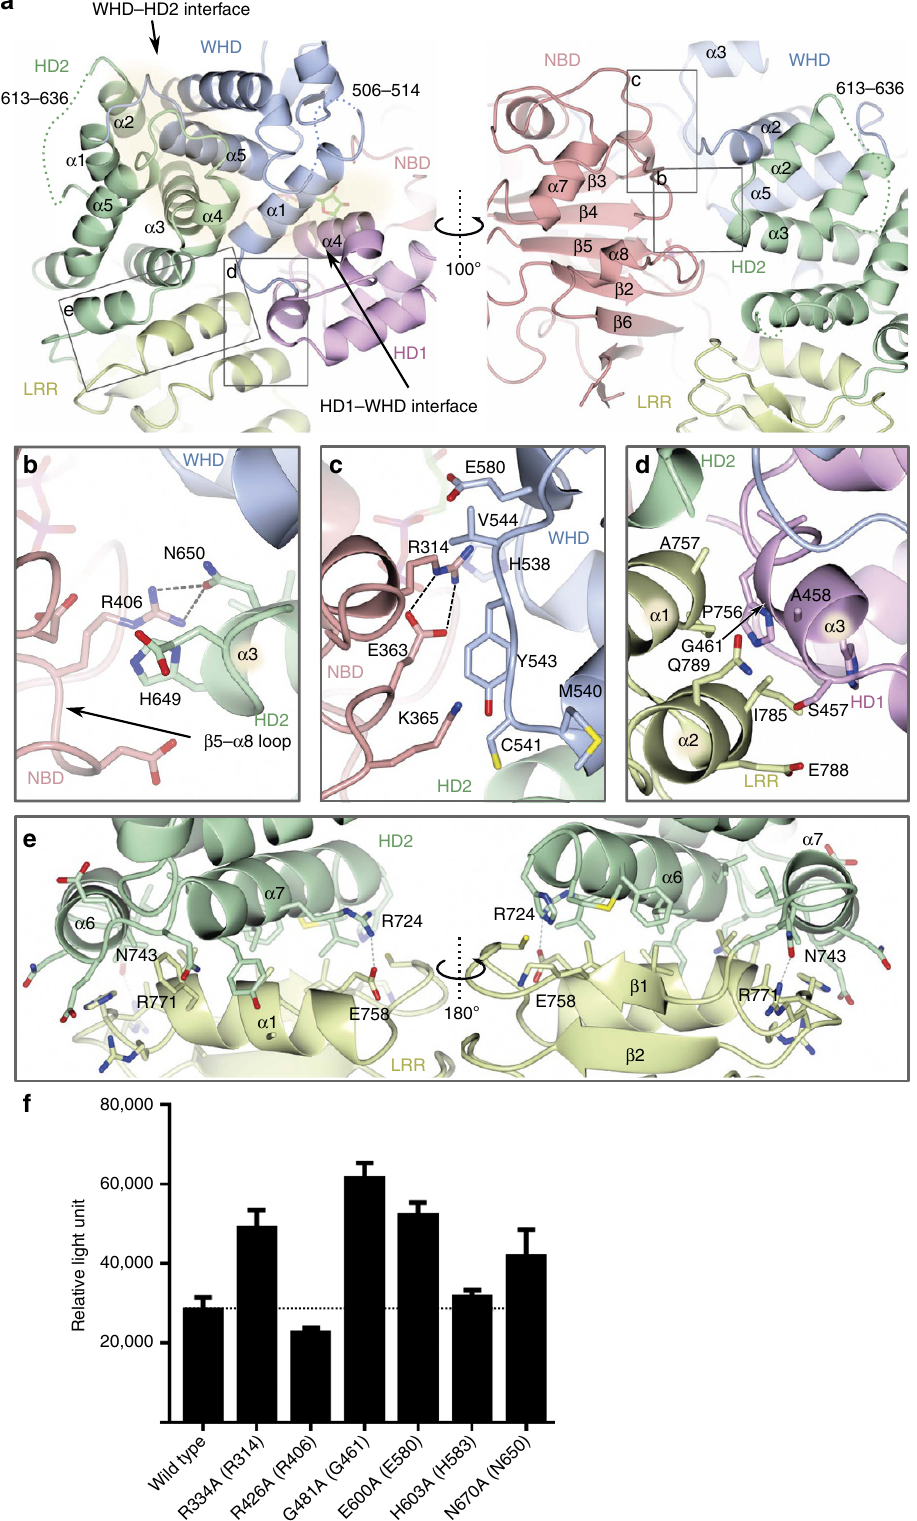
Figure 2 | Inter-domain interactions in the NOD domain. ( a ) Inter-domain interactions in the NOD domain viewed from two different orientations. The WHD–HD2 and HD1–WHD interfaces are highlighted by semi-transparent beige ovals. Structural elements involved in the interactions are labelled. ( b – e ) Magnified views of the NBD–HD2 ( b ), NBD–WHD ( c ), LRR–HD1 ( d ) and LRR-HD2 ( e ) interfaces. Each panel corresponds to the region indicated in a . Hydrogen bonds and salt bridges are shown as dashed grey lines. ( f ) Constitutive NF- k B activation by human NOD2 mutants associated with auto-inhibition by luciferase reporter assay using HEK293Tcells. Residues in parenthesis are derived from Oc NOD2. Data represent the mean relative light units (RLU) of NF- k B activity in the absence of MDP ( n ¼ 6, ± s.d.). Dotted lines indicate activity of wild-type